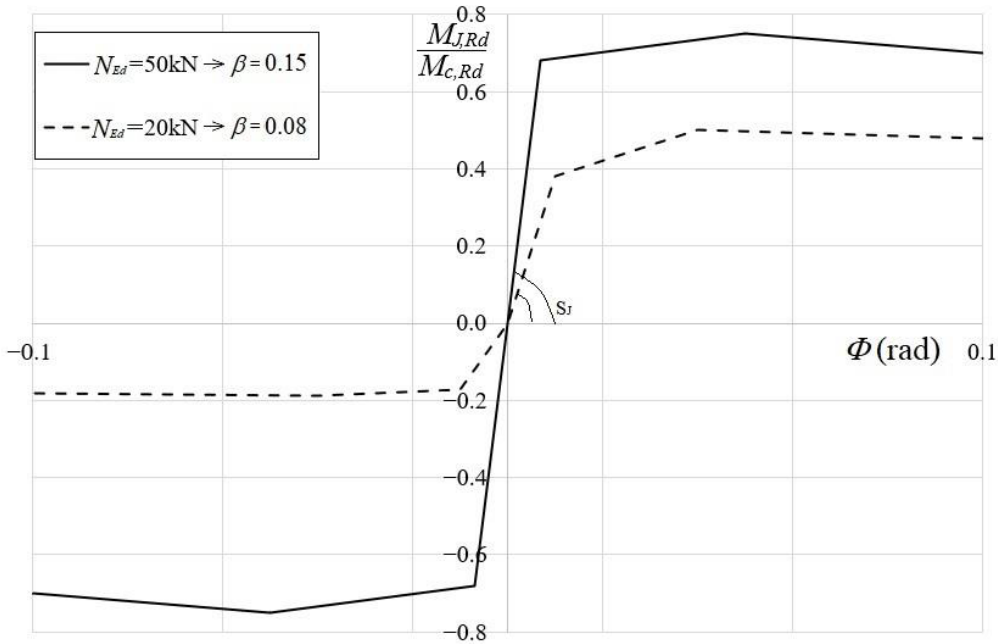
Figure 7. The considered moment-rotation relationship for base-plate connections.